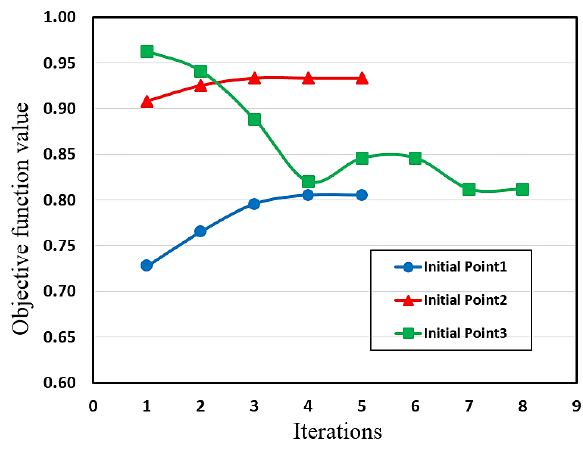
Figure 11. Performance of the sequential quadratic programming (SQP) method when starting from different initial points.